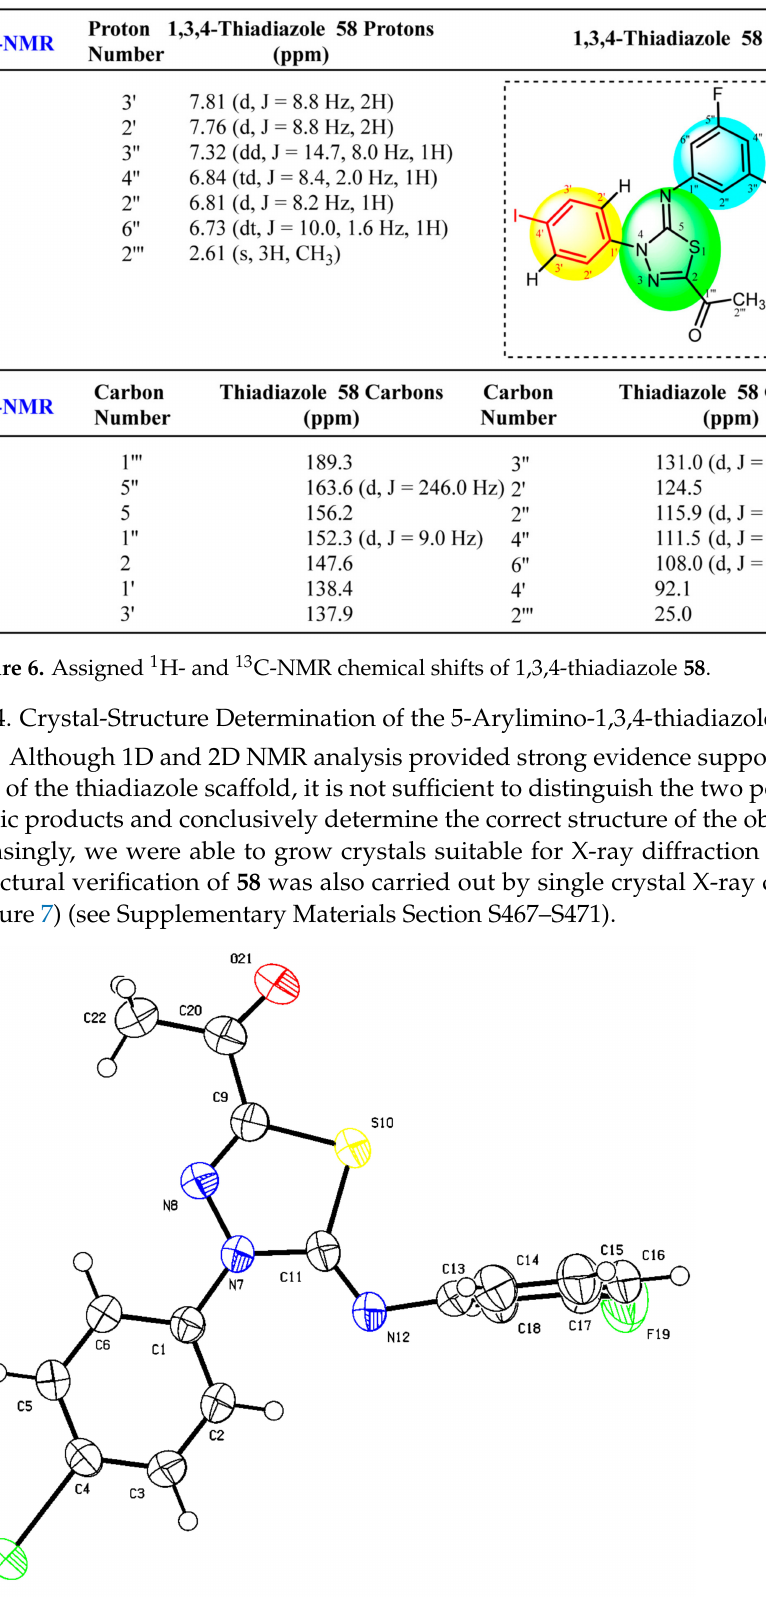
Figure 7. Thermal ellipsoid plots of ( Z )-1-(5-((3-fluorophenyl)imino)-4-(4-iodophenyl)-4,5-dihydro- 1,3,4-thiadiazol-2-yl)ethan-1-one ( 58 ) with ellipsoids drawn at 50% probability level (Deposition Number 2178549 ). For bond distances (Å) and angles (deg), see Supplementary Materials